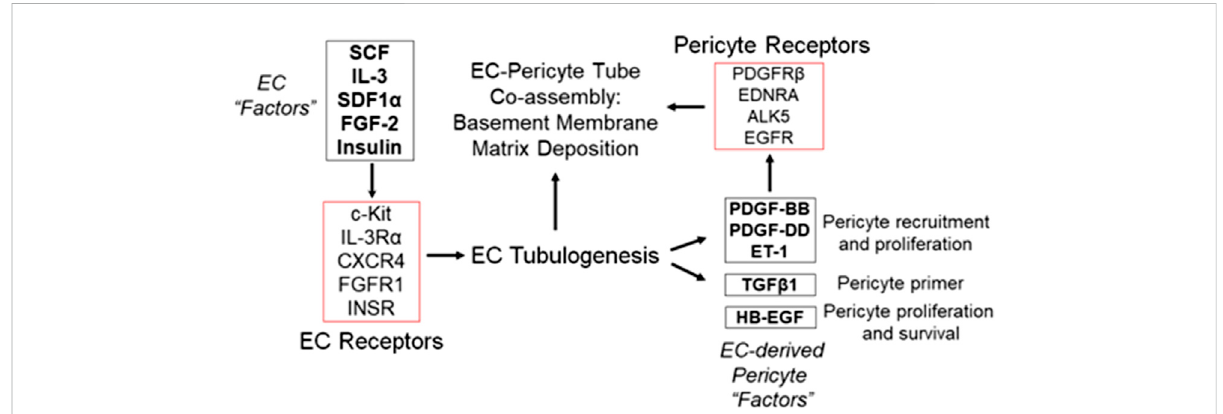
FIGURE 3 De fi ning the growth factors and peptides that are required for both ECs and pericytes to co-assemble into human capillary tube networks. (A) Using a de fi ned serum-free system in 3D collagen or fi brin matrices, the growth factor and peptide requirements for human EC-pericyte tube co- assembly were determined. A fi ve growth factor combination consisting of SCF, IL-3, SDF-1 α , FGF-2 and insulin ( “ Factors ” ) has been shown to stimulate all aspects of vascular morphogenesis including EC lumen and tube assembly as well as sprouting behavior. Additional work demonstrated a requirement for ECs in stimulating pericytes to recruit to tubes, proliferate, and induce basement membrane deposition. Five EC- derived factors including PDGF-BB, PDGF-DD, ET-1,TGF β 1,and HB-EGFwere found to work together to promotethese events and their functional roles during this process are